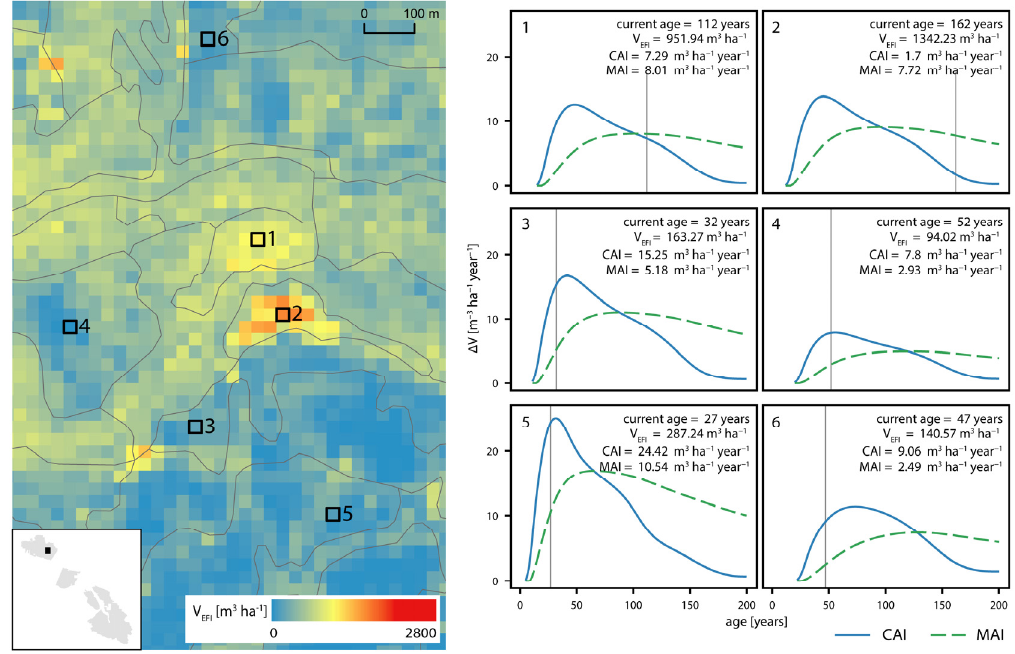
Figure 4. Current annual increment (CAI) and mean annual increment (MAI) curves for six exemplar cells located in different forest stands. The left panel represents a subset of the study area with the current volume estimates derived with EFI modeling (V EFI ), stand borders (grey lines), and the location of the chosen cells. The right panel contains CAI and MAI curves for these cells. Grey vertical lines depict the current age assigned to each cell. Text boxes contain information on cell age, volume, and current growth (CAI and MAI).